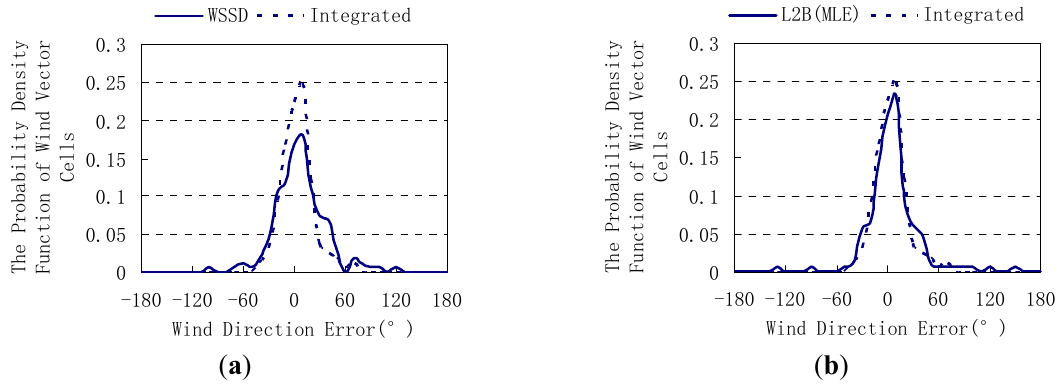
Figure 3. The probability density function of wind vector cells at each directional error in the nadir region: ( a ) comparisons between the traditional WSSD and the integrated algorithm and ( b ) comparisons between the integrated algorithm and the L2B (MLE) algorithm.